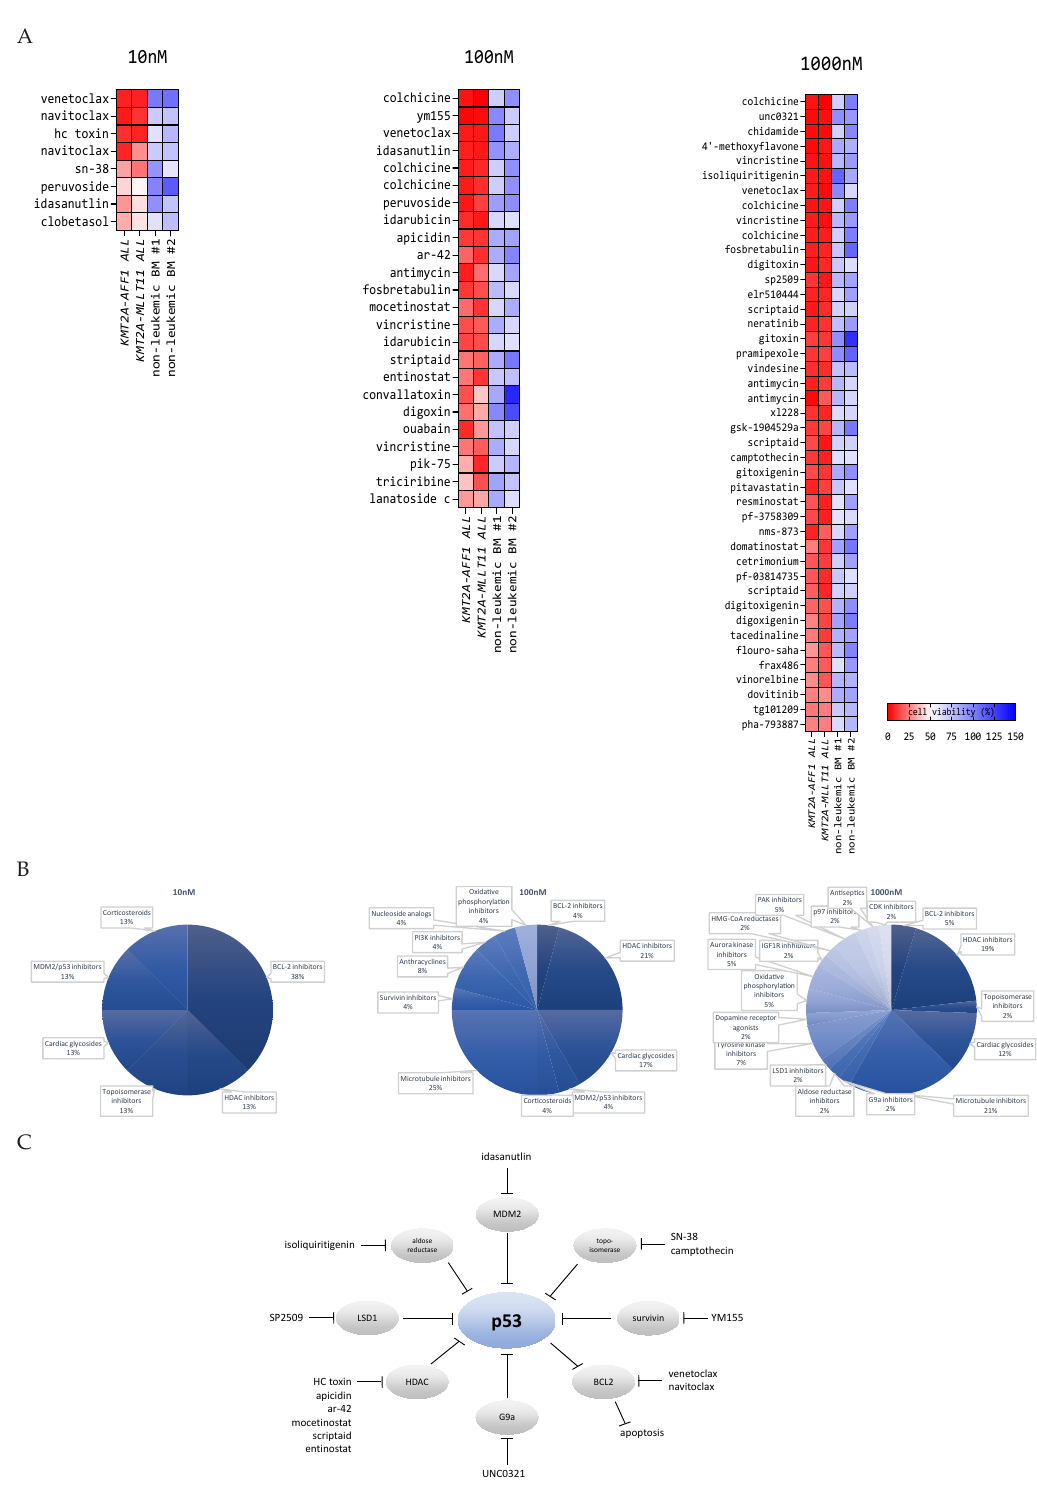
Figure 1. Drug candidates identified in the high-throughput screening on primary KMT2A -rearranged infant ALL cells and non-leukemic bone marrow cells favor p53 signaling: ( A ) heatmap